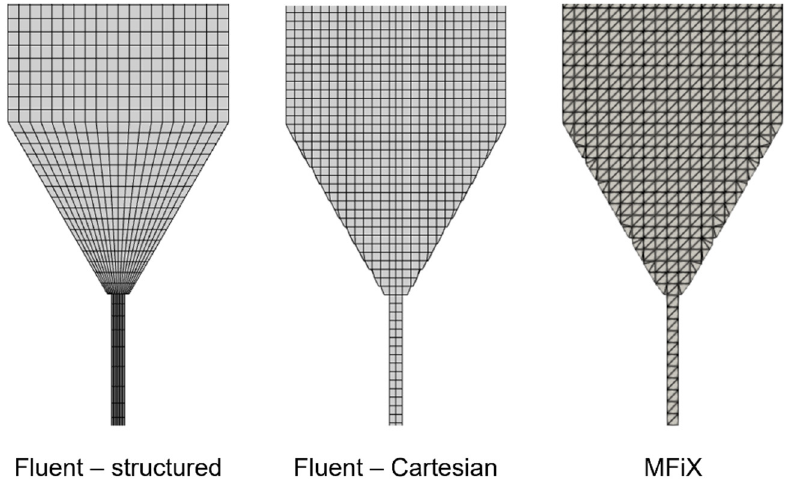
Figure 1. The three employed meshes. Please note that the upper portion of the mesh is not shown as it is not relevant for the comparison, and that the diagonals of the squares in the MFiX mesh are only aesthetic.